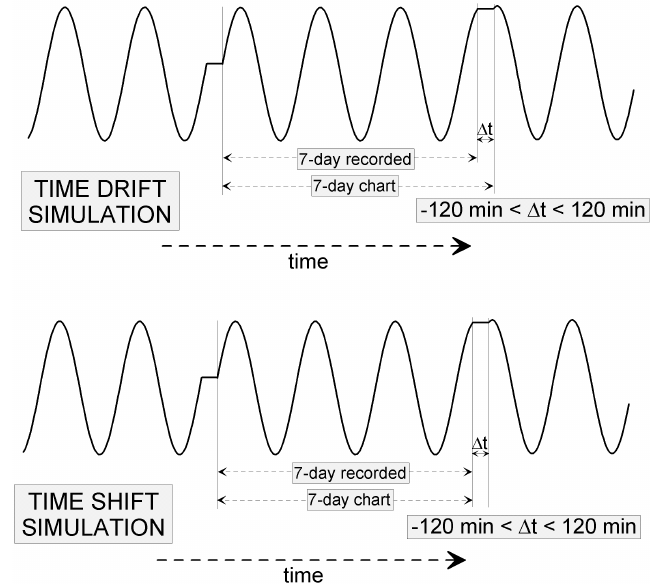
Fig. 1. Scheme of time drift and time shift